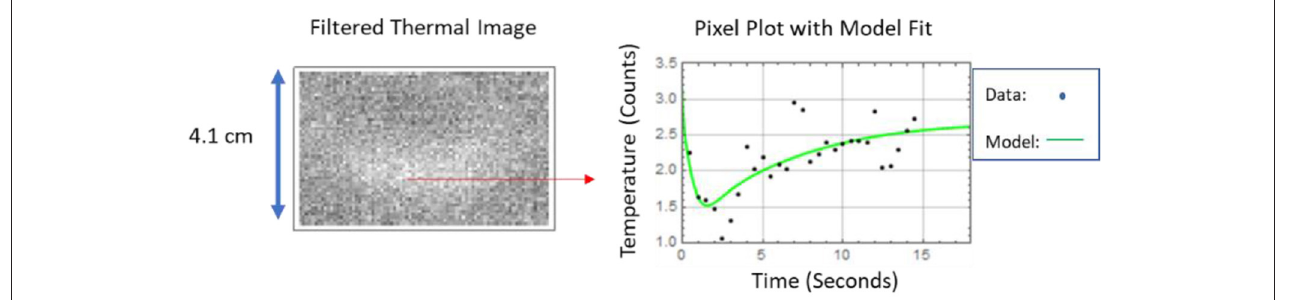
FIGURE 15 | Example model fit to the filtered thermal data.